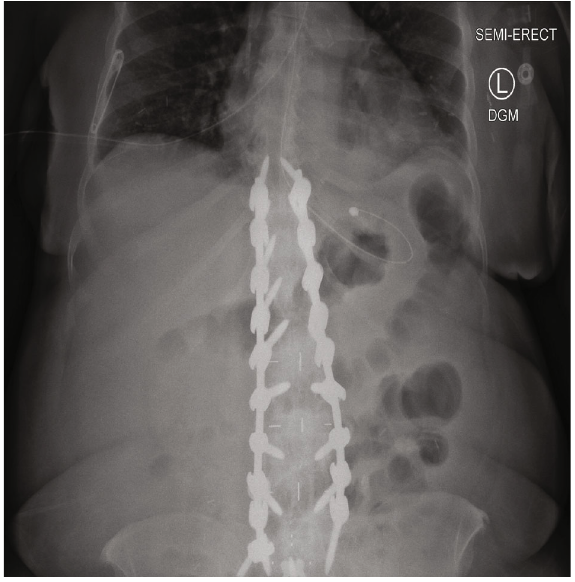
Figure 3: Postoperative abdominal X-ray. Bowel gas pattern is nonobstructive and postsurgical changes from spinal